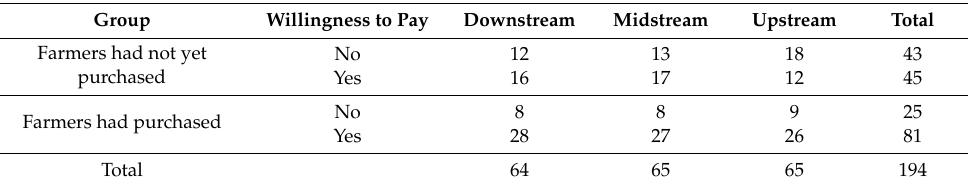
Table 5. Farmers’ willingness to pay (WTP) by location and previous purchase of agricultural production cost insurance.